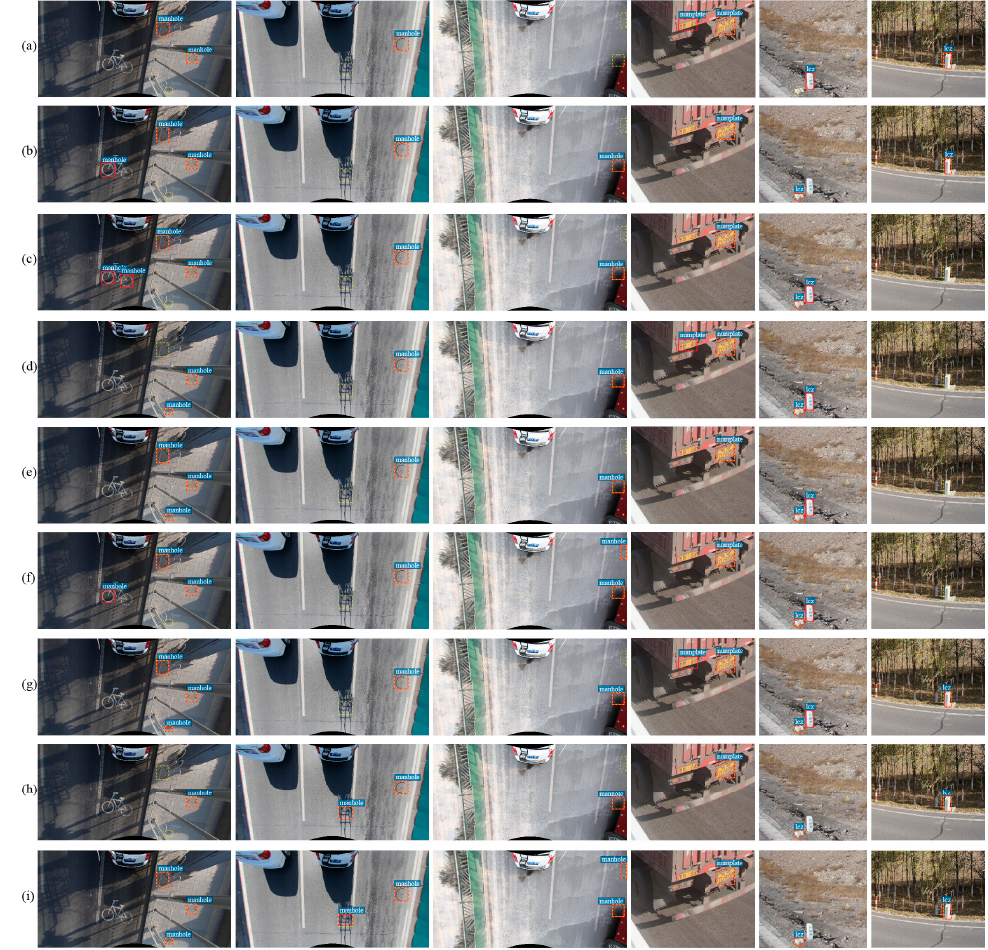
Figure 8. Comparison of small urban element detection on UED dataset for different methods. ( a ) ResNeXt; ( b ) FPN; ( c ) DCN; ( d ) TridentNet-Fast; ( e ) Cascade R-CNN; ( f ) Mask R-CNN; ( g ) Cascade Mask R-CNN; ( h ) RetinaNet; ( i ) ours. Red is the predicted bounding box and yellow is the ground reference bounding box.